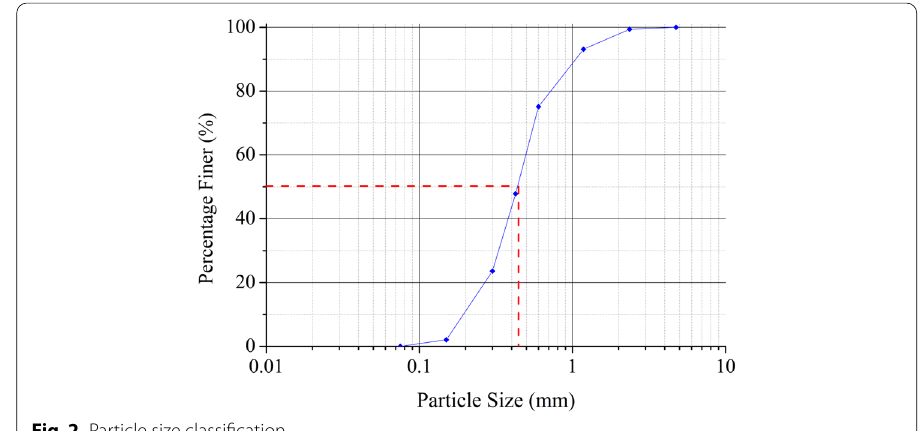
Fig. 2 Particle size classification